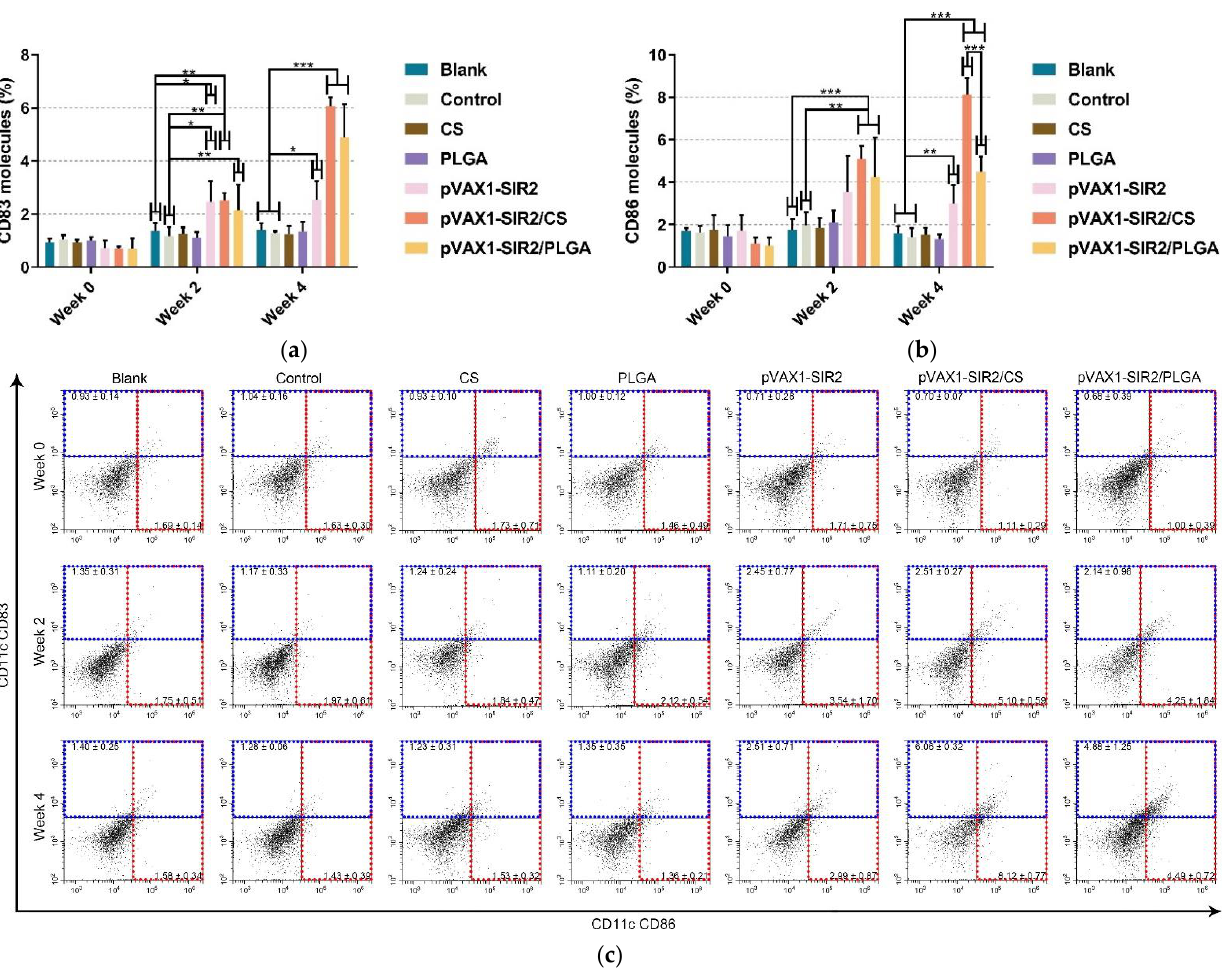
Figure 7. Analysis of splenic DC maturation at week zero, two, and four. The expression of CD83 and CD86 molecules on DCs was evaluated by flow cytometry. Bar graph showed the ratio of CD83 ( a ) and CD86 ( b ) molecules on the surface of splenic DCs, and the dot plots ( c ) showed the percentage of CD11c + CD83 + and CD11c + CD86 + cells. Each sample was investigated once, and values were analyzed by one-way ANOVA analysis followed by Dunnett ’ s test. Values between the pVAX1-SIR2/CS and pVAX1-SIR2/PLGA group were estimated by the independent t -test. Values were shown as mean ± SD (n = 5). * p < 0.05, ** p < 0.01, and *** p < 0.001 compared with blank or control group.